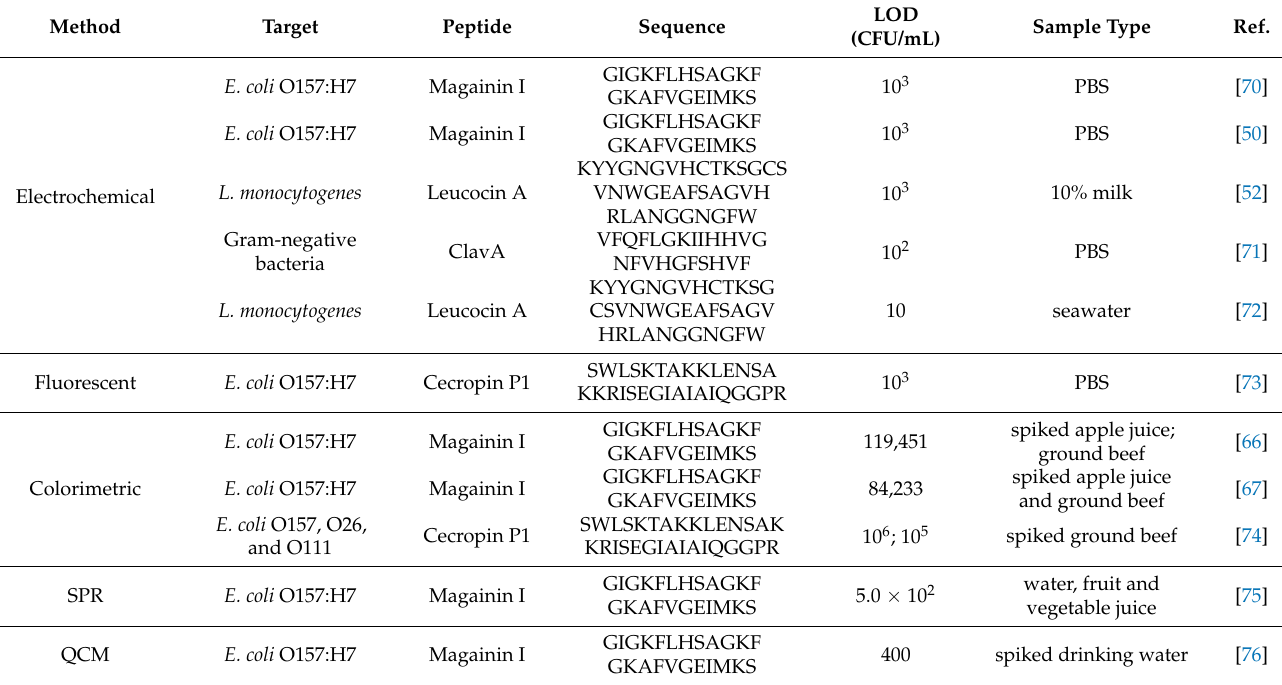
Table 1. Comparison of some peptide-based detection methods for foodborne pathogenic bacteria. Method Target Peptide Sequence